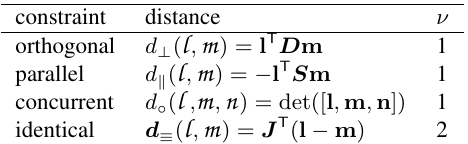
Table 1. Distance measures according to (Meidow and Lucks, 2019) for three straight lines l , m , and n with corresponding de- grees of freedom ν . See the text for explanation of the variables.